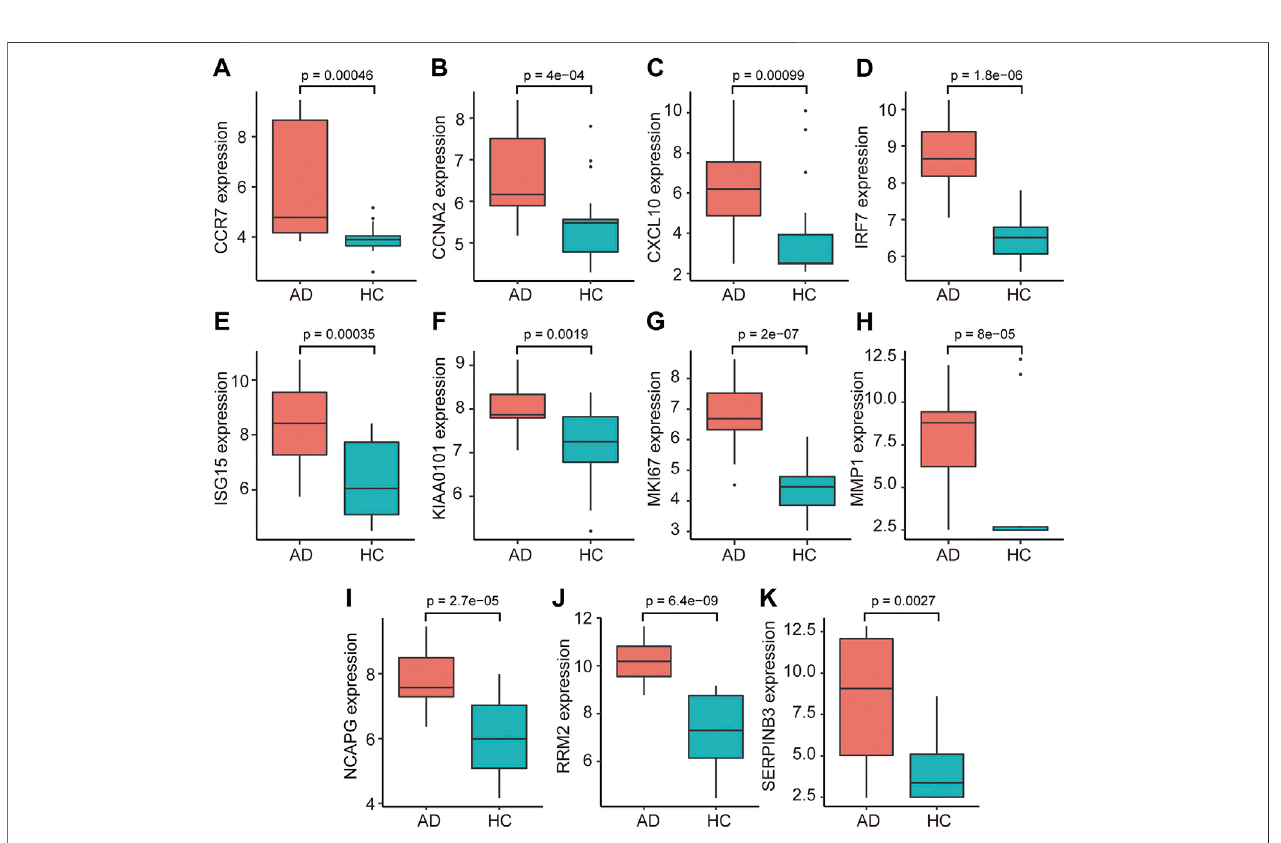
FIGURE6| Therelativeexpression levels of11candidate hub genes,i.e., ( (A) CCR7, (B) CCNA2, (C) CXCL10, (D) IRF7, (E) ISG15, (F) KIAA0101, (G) MKI67, (H) MMP1, (I) NCAPG, (J) RRM2, and (K) SERPINB3, validated using GSE120721. AD, atopic dermatitis; HC, healthy control.